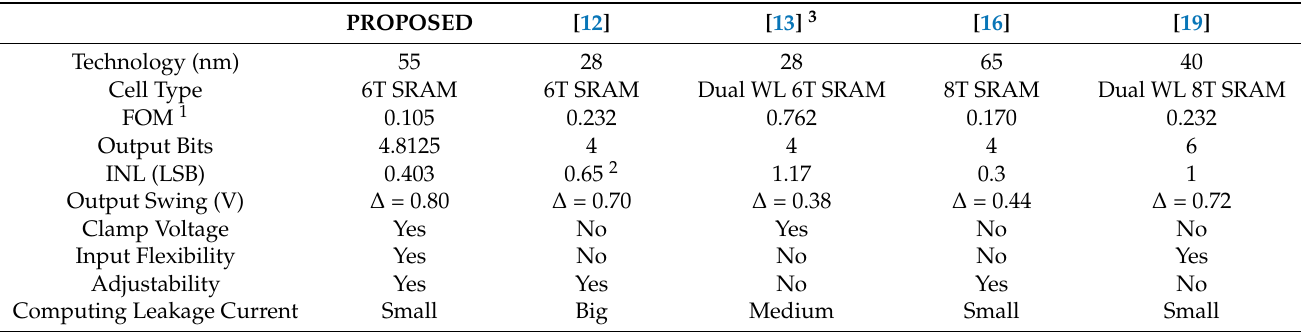
Table 2. Comparison of different schemes for multi-row reading in SRAM-based analog compute CIMs.